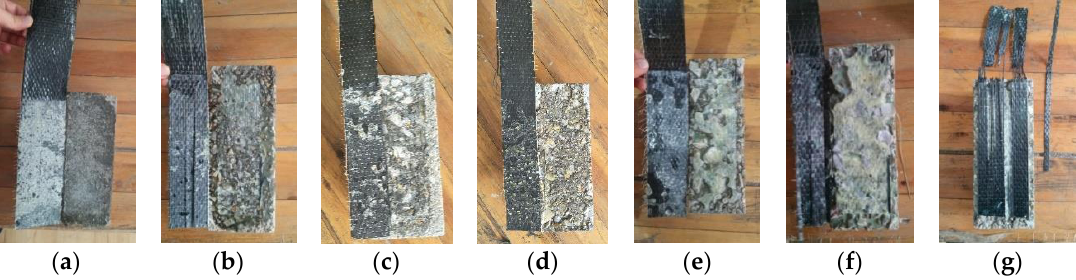
Figure 7. Failure modes of CFRP-concrete interfaces: ( a ) f0; ( b ) f1; ( c ) f2; ( d ) f3; ( e ) f4; ( f ) f5; ( g ) non-ideal failure mode.